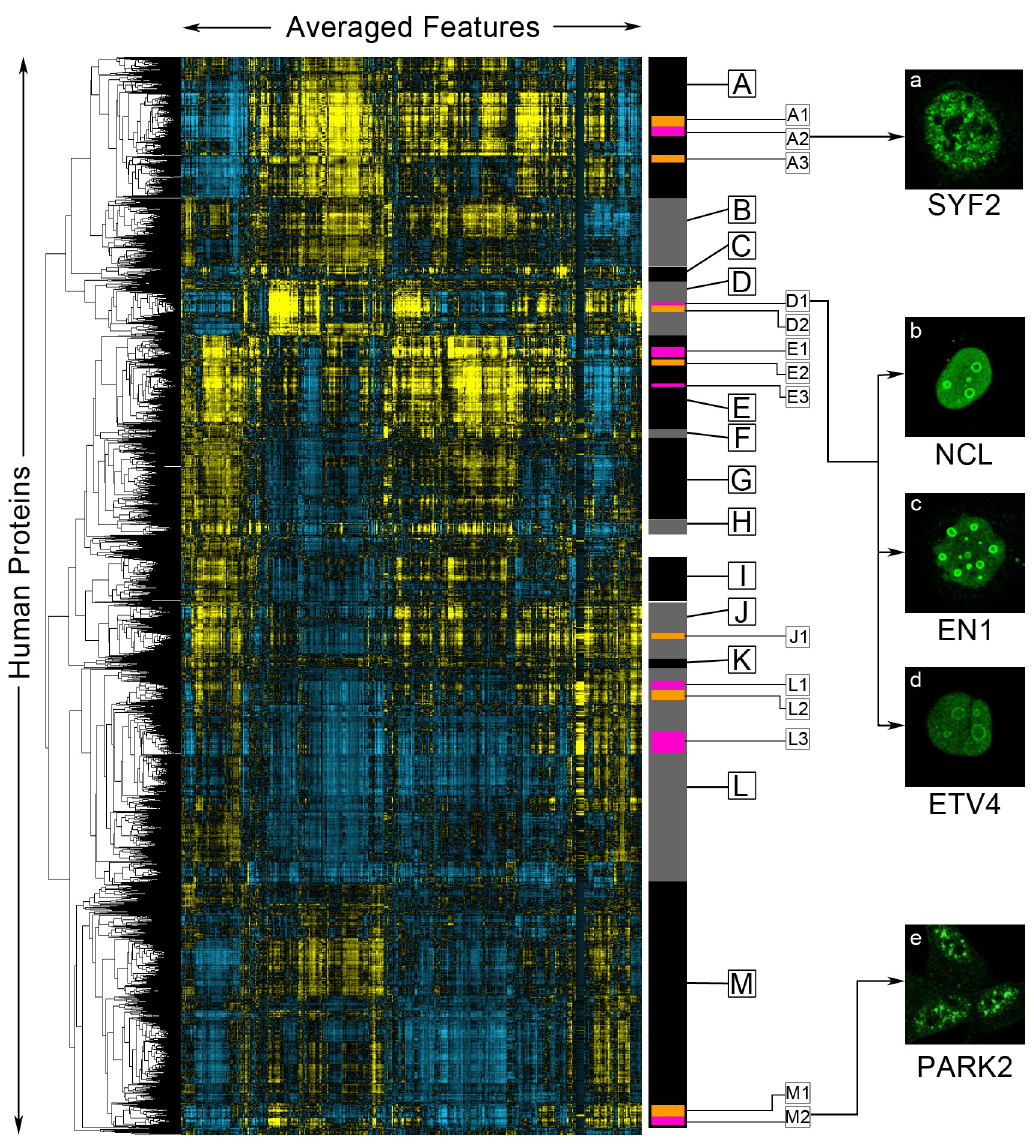
Fig 4. A clustered heat map of paired cell inpainting feature representation of proteins in the Human Protein Atlas. Proteins are ordered using maximum likelihood agglomerative hierarchical clustering. We visualize the average of paired cell inpainting features for all cells for each protein as a heat map, where positive values are colored yellow and negative values are colored blue, with the intensity of the color corresponding to magnitude. Columns in this heat map are features, while rows are proteins. Features have been mean-centered and normalized. We manually select major clusters (grey and black bars on the right), as well as some sub-clusters within these major clusters (orange and purple bars on the right), for enrichment analysis, presented in Table 3. On the right panels (panels a-e), we show representative examples of the protein channel (green) of cells from proteins (as labeled) in the clusters indicated by arrows from the images.